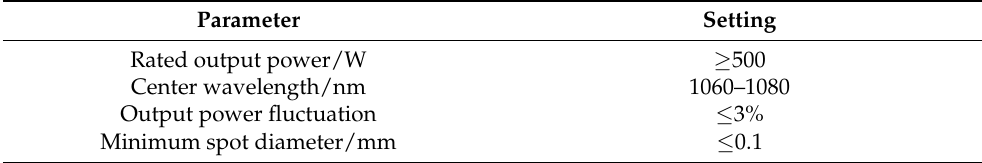
Table 1. Primary working parameters of the SLM platform. Parameter